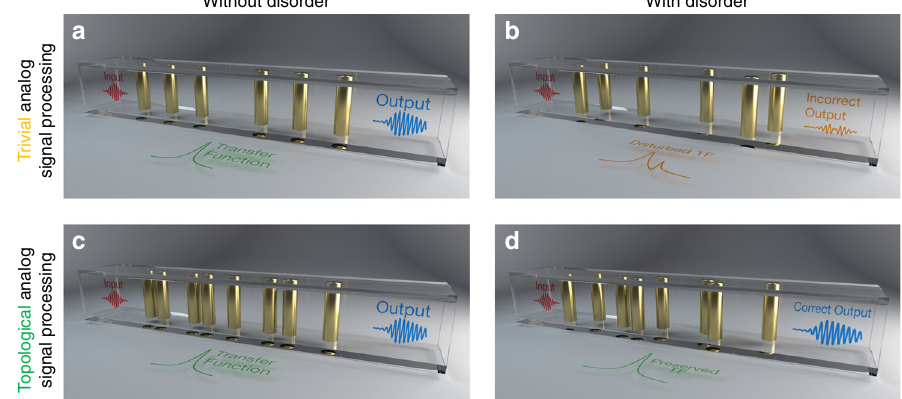
Fig. 1 Robust topological analog signal processing. We consider the possibility to process time-domain wave signals by engineering their transfer function as they propagate through an engineered solver. a A fi rst-order differential equation solver is constructed from resonant tunneling through a crystal defect. The output signal is the solution of the differential equation associated with the transfer function of the system. b In the presence of geometrical defects, like slight position shifts, the signal processing functionality achieved with the trivial equation solver of panel ( a ) is completely destroyed. c To make the signal processing robust, we propose instead to build the target transfer function of the system from resonant tunneling through a topological edge mode. d Markedly different from the trivial equation solver of panels ( a ) and ( b ), the output of the topological solver is left totally unaffected by the